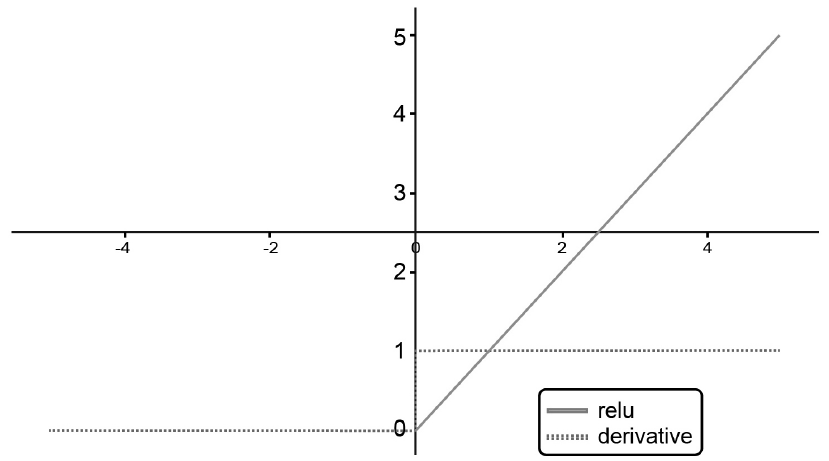
Figure 4. ReLU and its derivative